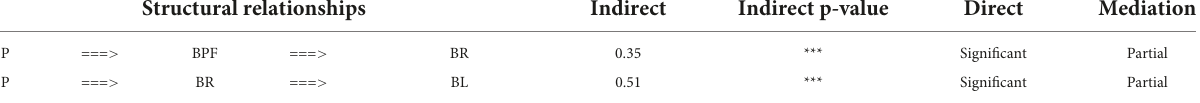
TABLE 6 Mediation